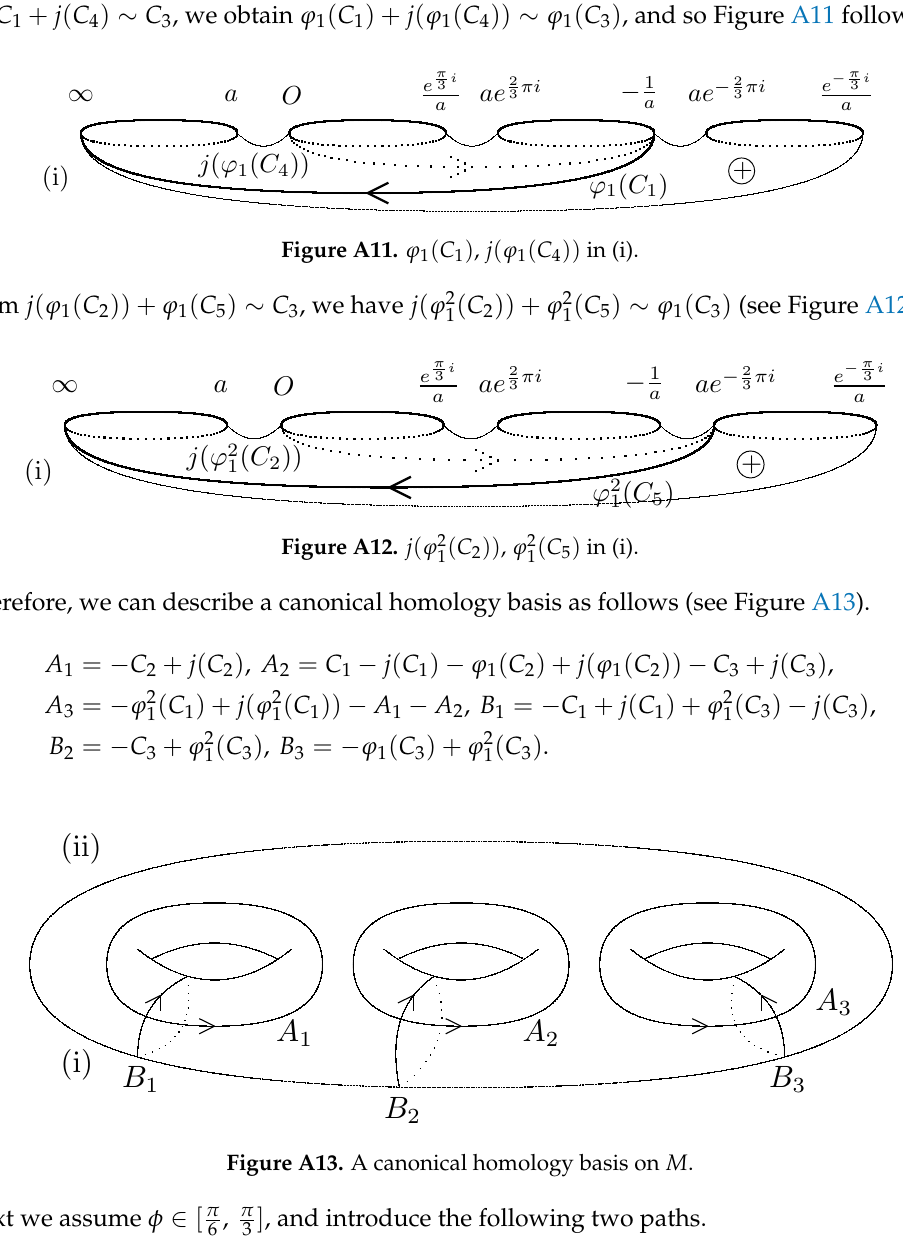
Figure A10. ϕ 1 ( C 3 ) , j ( ϕ 1 ( C 3 )) in M .